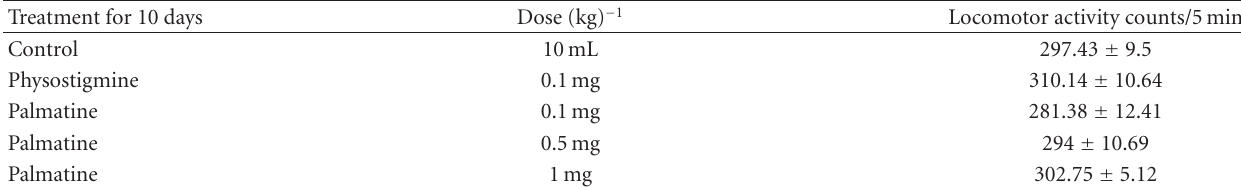
Table 4: E ff ect of palmatine and physostigmine on locomotor activity of mice.